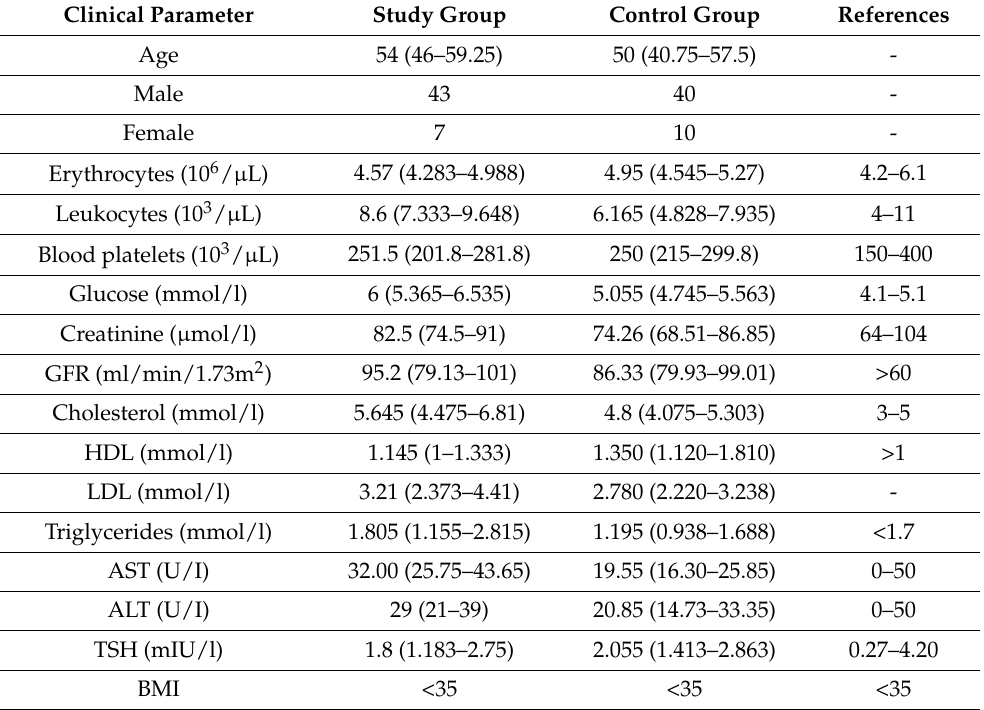
Table 1. Clinical characteristics of the ACS patients and healthy volunteers. Clinical